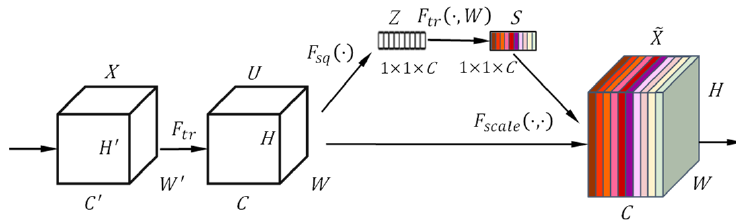
Figure 7. Squeeze-and-Excitation Networks (SE-Net).